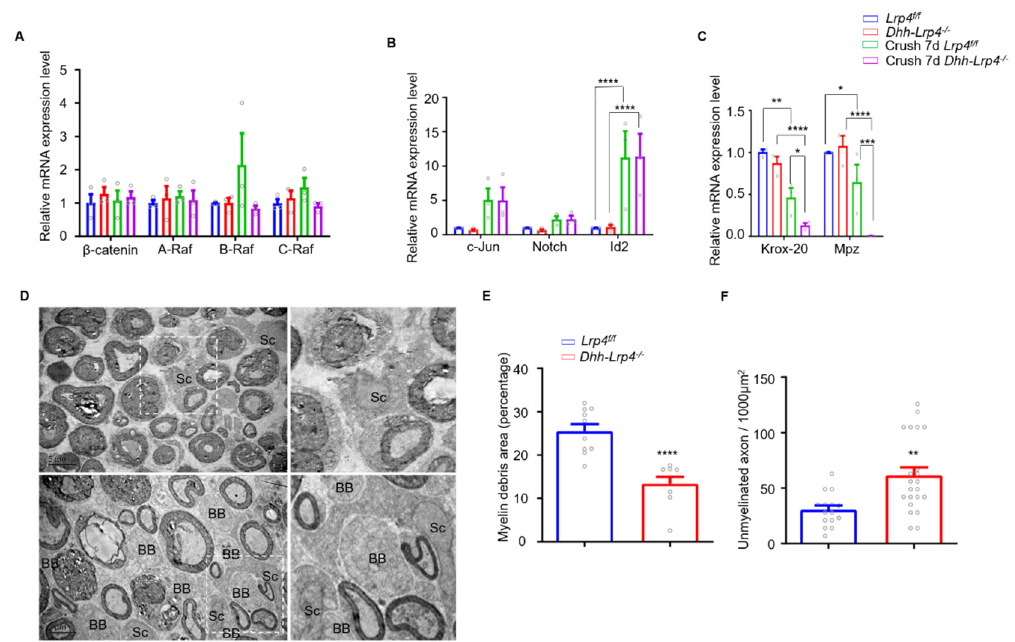
Figure 7. Lrp4 deficiency promotes demyelination and downregulates Krox-20 after nerve injury. ( A ) The β -catenin and MAPK pathway-related mRNA levels did not differ between the control and cKO mice (3 mice/group). ( B ) The mRNA levels of c-Jun, Notch, and Id2 were comparable between the control and cKO mice before injury and at 7 dpc. **** p < 0.0001 (3 mice/group). ( C ) The mRNA levels of Mpz and Krox-20 were decreased in the cKO mouse sciatic nerves compared with the control mice at 7 dpc. * p < 0.05, ** p < 0.01, *** p < 0.001, **** p < 0.0001 (3 mice/group). ( D ) Representative electron micrograph of control and cKO sciatic nerves. The cKO mice showed lower amounts of myelin debris and more